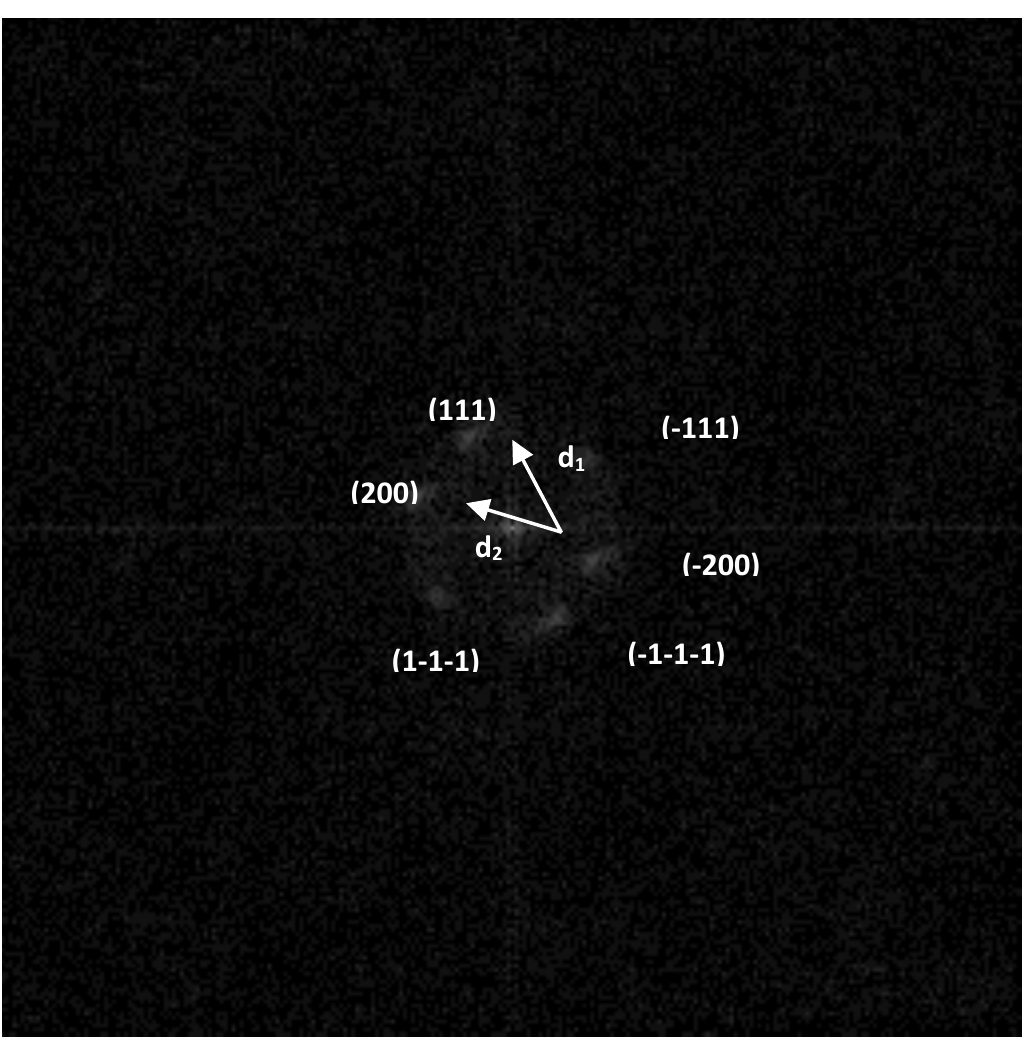
Figure 3. Simulation of the electron diffraction pattern for the group of atoms circled in Figure 2 and assignment for face-centered cubic (fcc) structure.